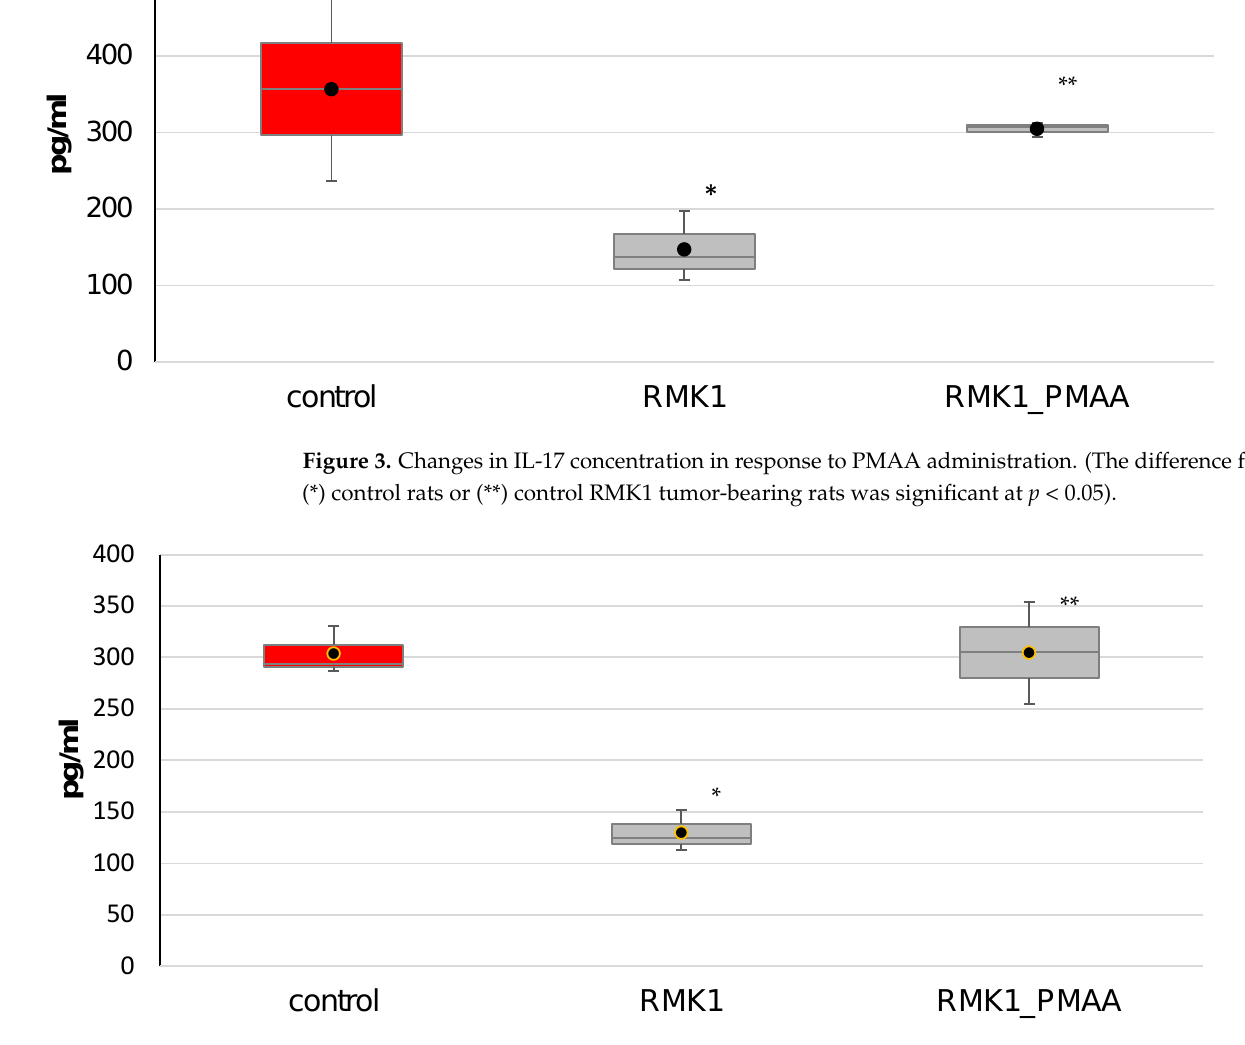
Figure 4. Changes in TGF- β 1 concentration in response to PMAA administration. (The difference from (*) intact rats or (**) control RMK1 tumor-bearing rats was significant at p < 0.05).